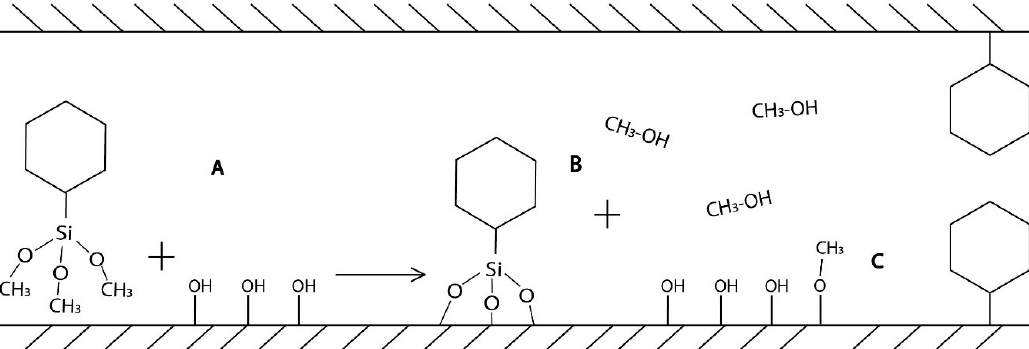
Figure 4. Schematic representation of possible reason for lower number of cyclohexyl groups in comparison to 3-aminopropyl groups. In the process of modification ( A ) the methanol was released as a by-product ( B ) and slowly diffuse into the reaction media. Alcohols can bind to the MPS surface and modify it ( C ), which results in the lower number of free hydroxyl groups.